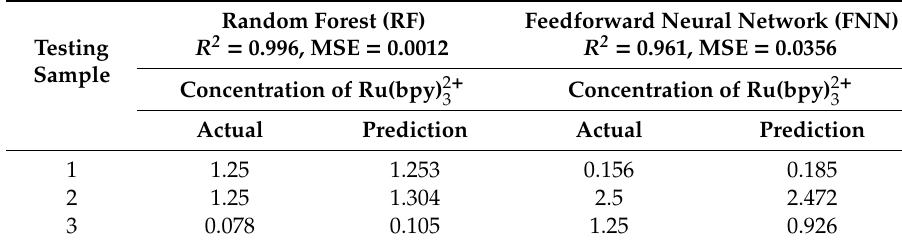
Figure 7. Actual versus predicted values of the concentration of Ru(bpy) 32+ obtained for validation set using ( a ) random forest and ( b ) feedforward neural network. Table 1. Actual versus predicted values of the concentration of Ru ( bpy ) 2 + using the random forest and the feedforward neural